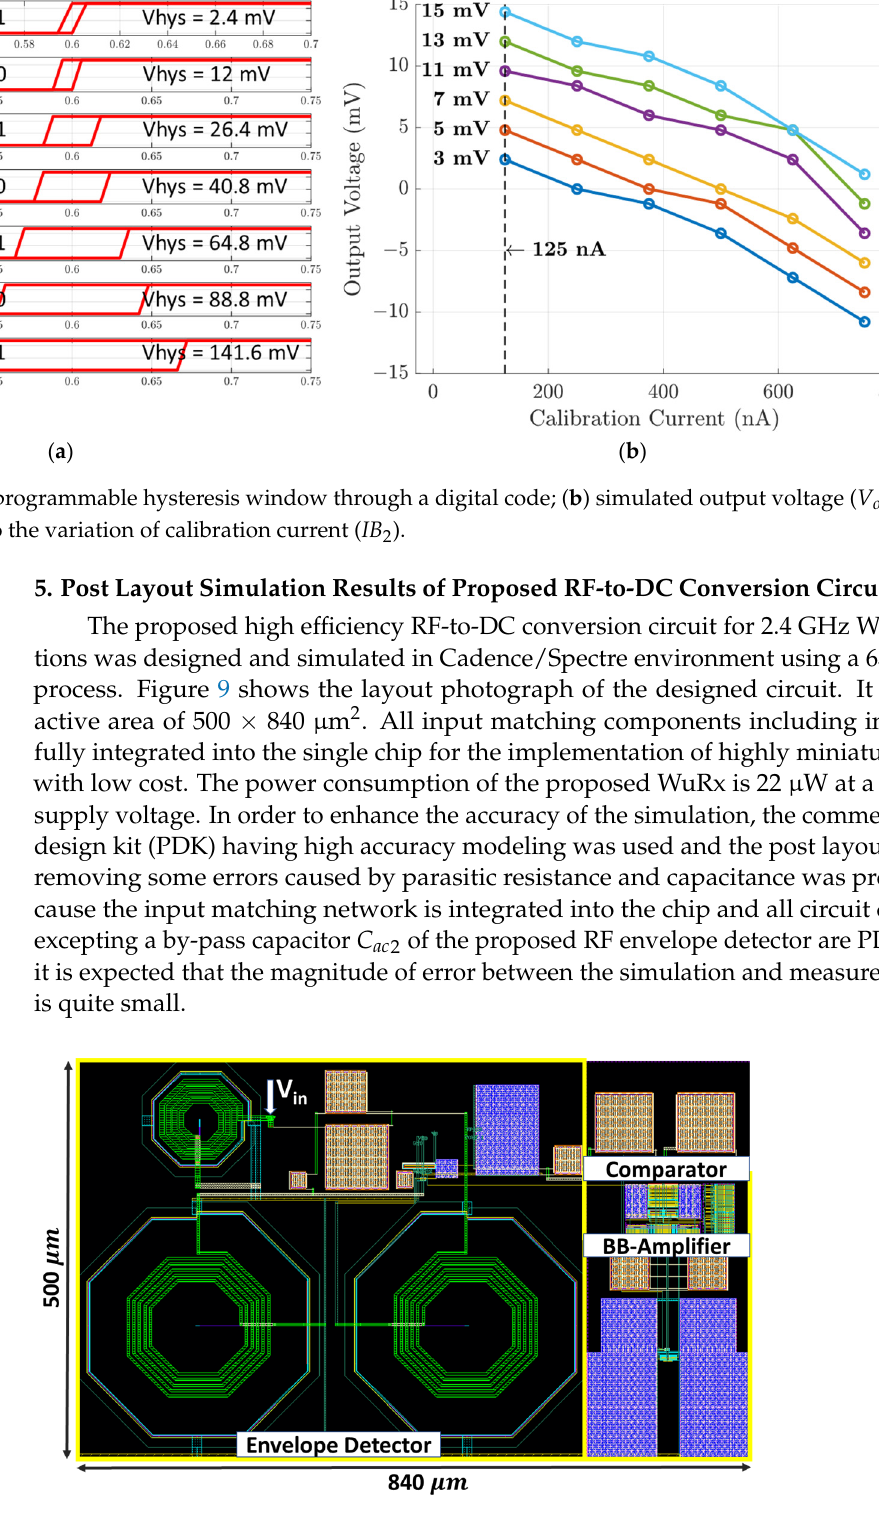
Figure 9. Layout photograph of the designed circuit.